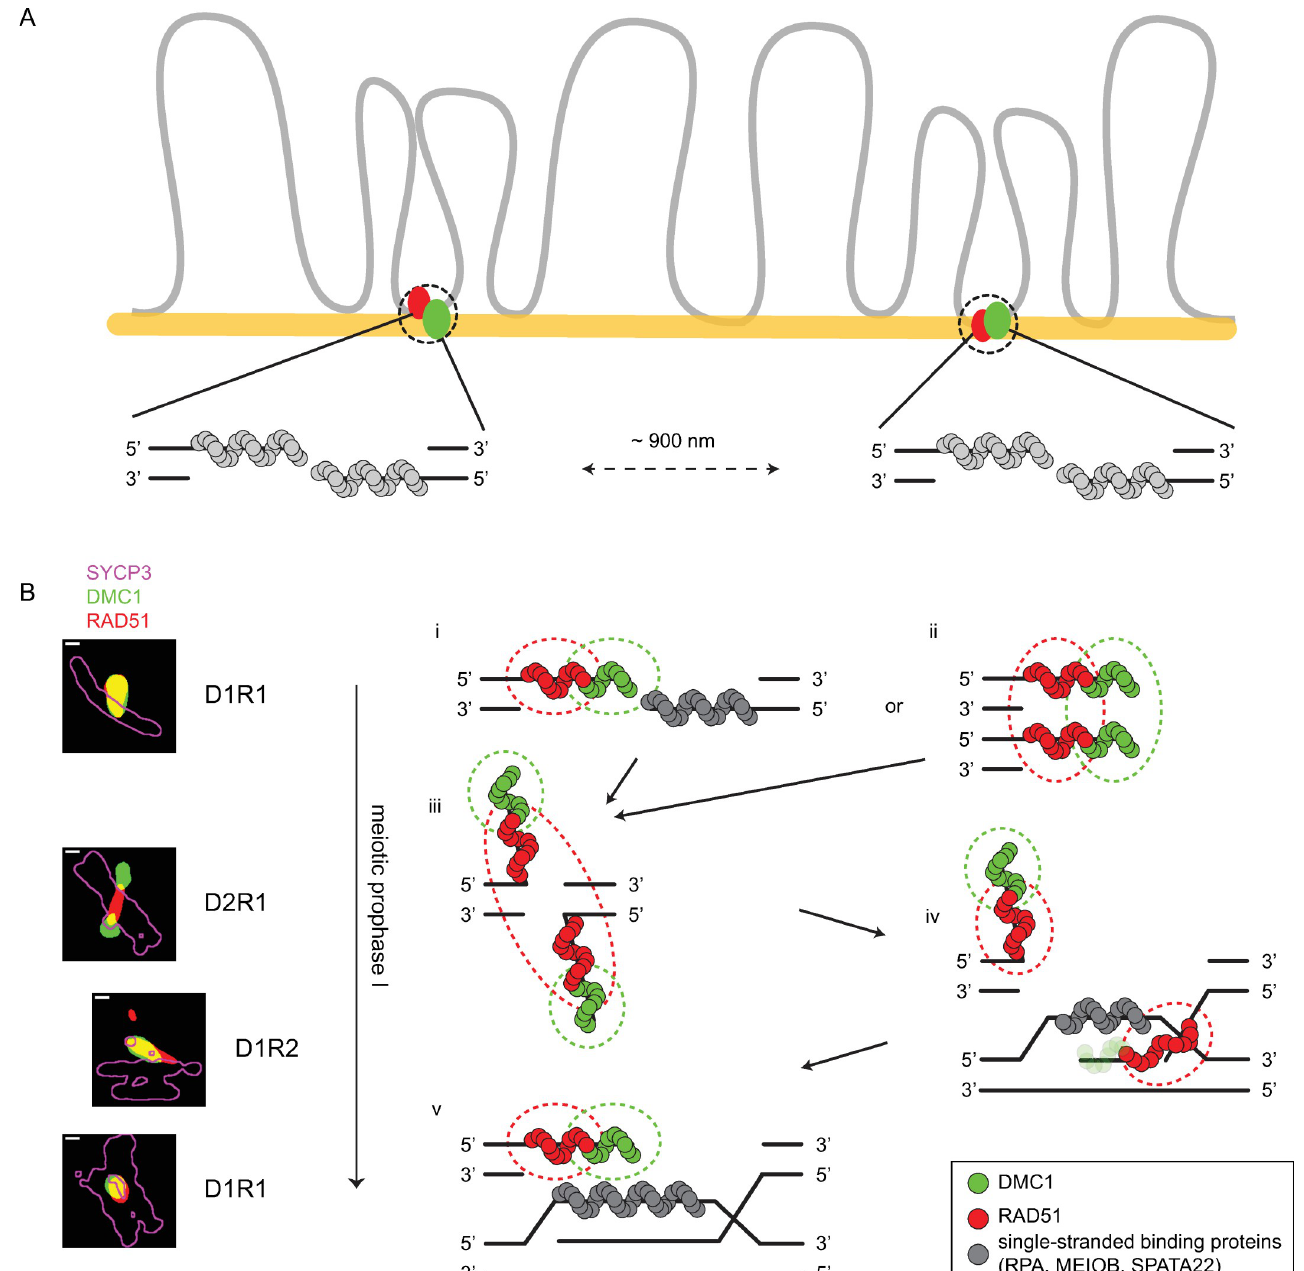
Fig 10. Schematic model for recombinase loading at early steps of homologous recombination pathway in mouse meiosis. A) Based on the nearest neighbor analysis of wild type and Hormad1 -/- recombinase nanofoci, we propose that in fixed mouse spread nuclei of wild types, two DSBs are on average ~900 nm apart. This schematic drawing provides an impression of how the SC (yellow) and chromatin (grey) relate to the actual DSBs. B) The ssDNA ends of a DSB are first loaded by ssDNA binding proteins (grey). These proteins will be replaced by recombinases. This schematic model for the recombinase loading during meiotic HR relates super-resolution microscopy configurations with loading patterns of RAD51 (red) and DMC1 (green). Dashed lines indicate the signal of recombinases in immunofluorescent dSTORM microscopy. D1R1 is the most frequent configuration, followed by a D2R1 and D1R2. Based on the frequency changes along the prophase, we propose that D1R1 (can) transit into D2R1 and, possibly via D1R2, back to D1R1. We favor two options for early D1R1 configurations: the first option involves recombinases loaded on one DSB end, where DMC1 is orientated at the 3’ end and RAD51 more towards the 5’ end, while the other end is bound by other ssDNA binding proteins (i). The second option is that D1R1 involves loading of recombinases on both ends as described for option 1, but those ends are in close proximity due to low-affinity homotypic interactions, and cannot be resolved (ii). In a subsequent stage, both ends have accumulated recombinases and the search for homolog starts whereby the ends undergo a conformation change (iii). DMC1 is loaded on the 3’ ends and moves further away, while the two RAD51 clusters cannot be resolved, resulting in one large RAD51 nanofocus. When strand invasion takes place, first DMC1 is